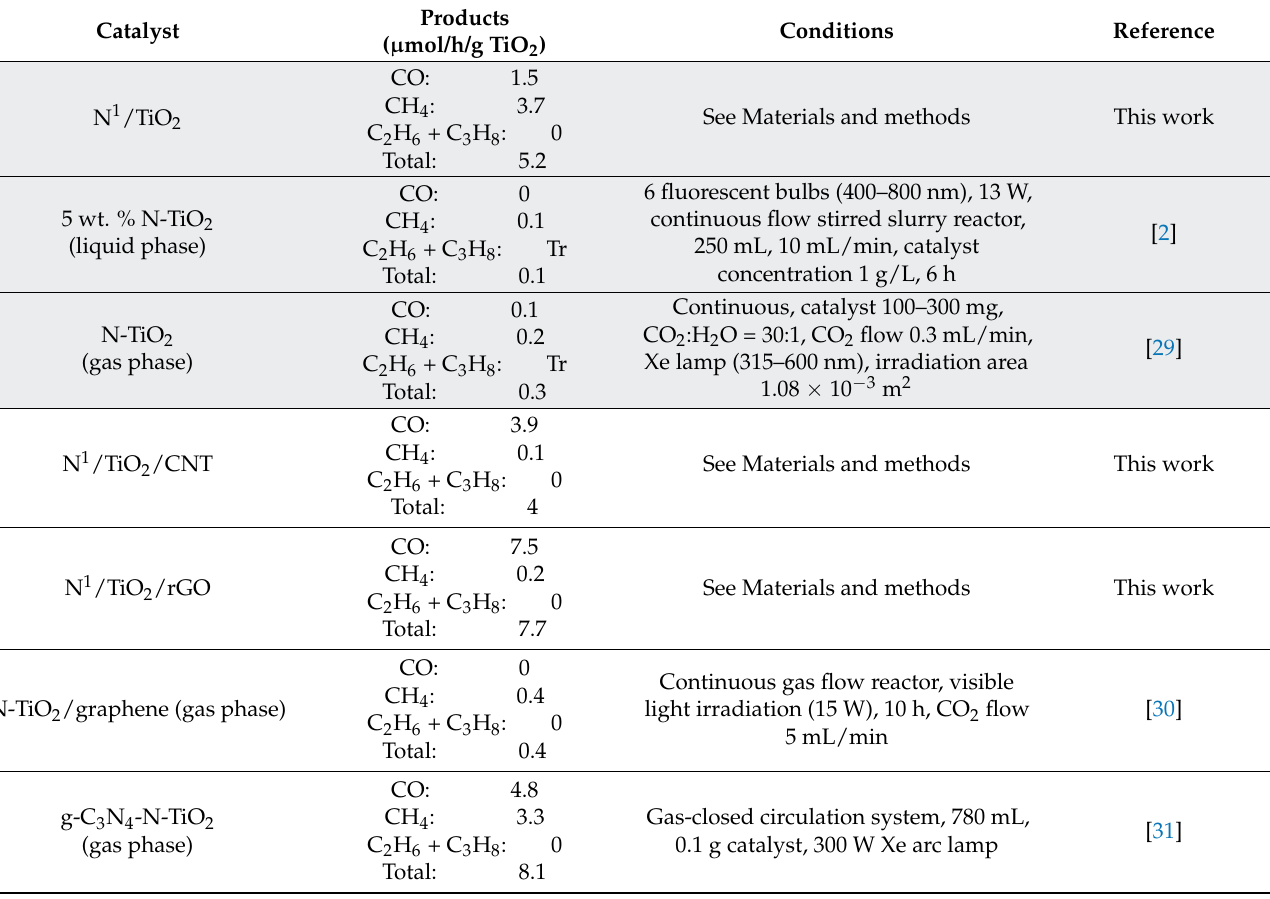
Table 3. Photocatalytic production rates of CO and hydrocarbons with N-doped TiO 2 -based photo- catalysts reported in the bibliography.